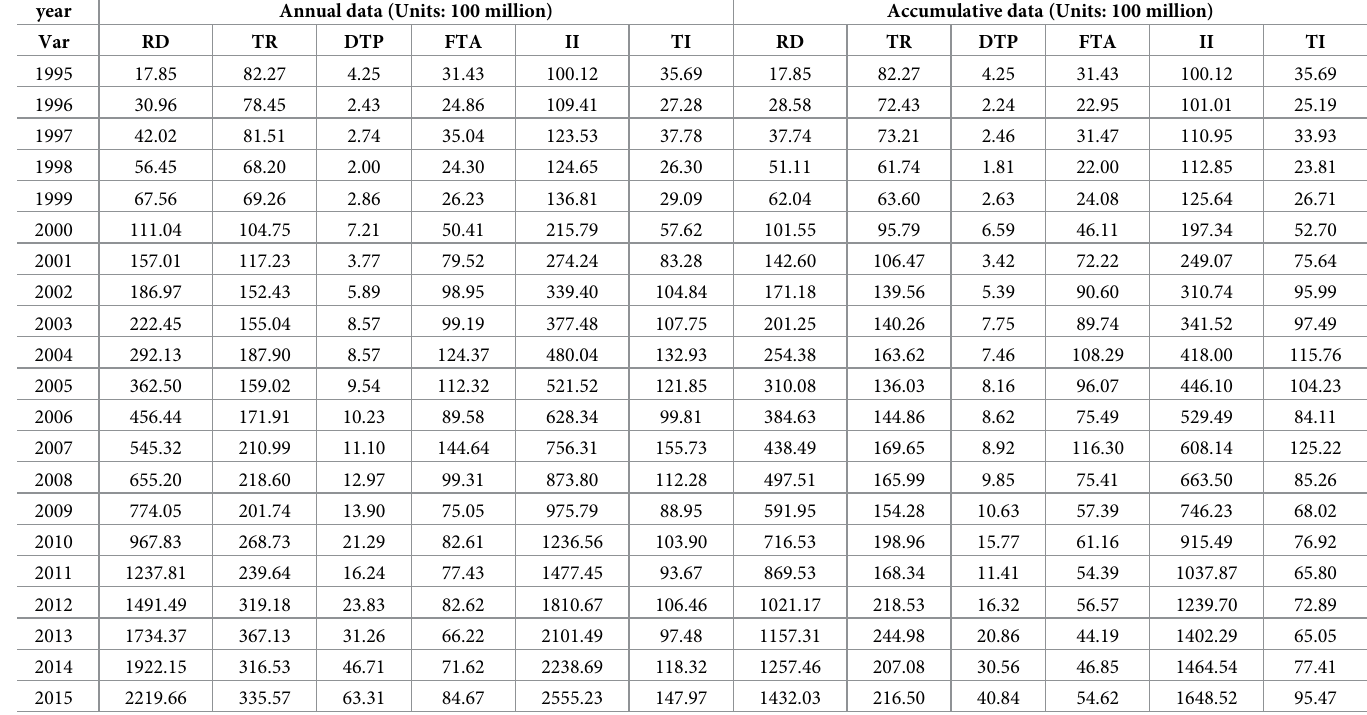
Table 4. Expenditures for technology innovation in the Chinese high-tech industry from 1995 to 2015. year Annual data (Units: 100